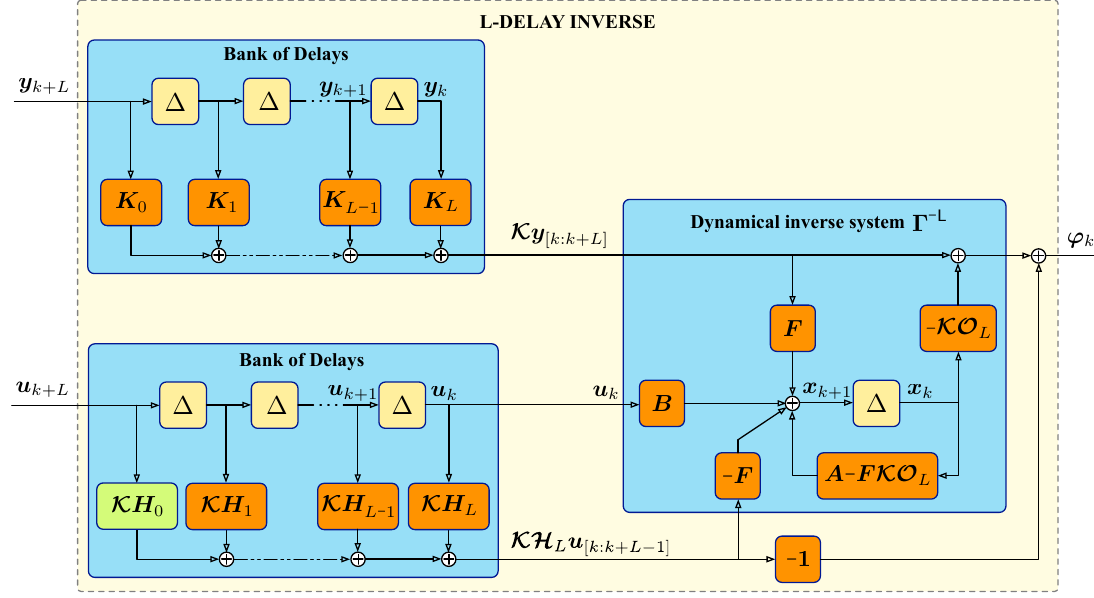
Figure 2. Structure of the L-delay inverse